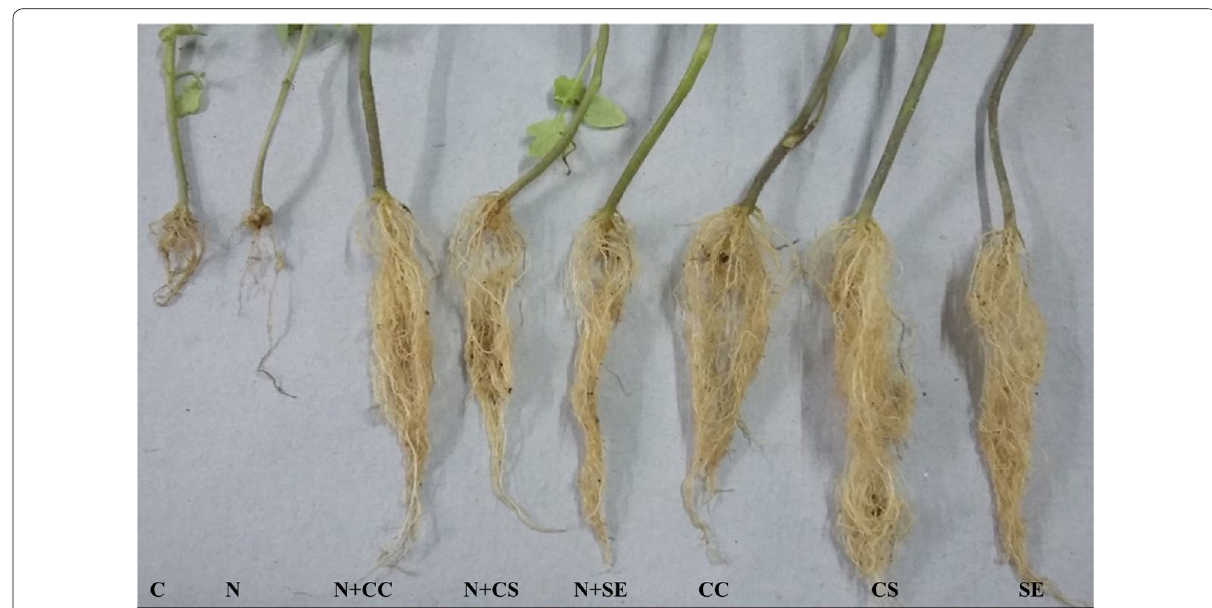
Fig. 4 In vivo protective effect of S. antibioticus strain M7 and its metabolites on root growth of Solanum lycopersicum plants infested with M. incognita ; C (water), N (Nematode) CC (cells of strain M7), CS (culture supernatant) and SE (EtOAc